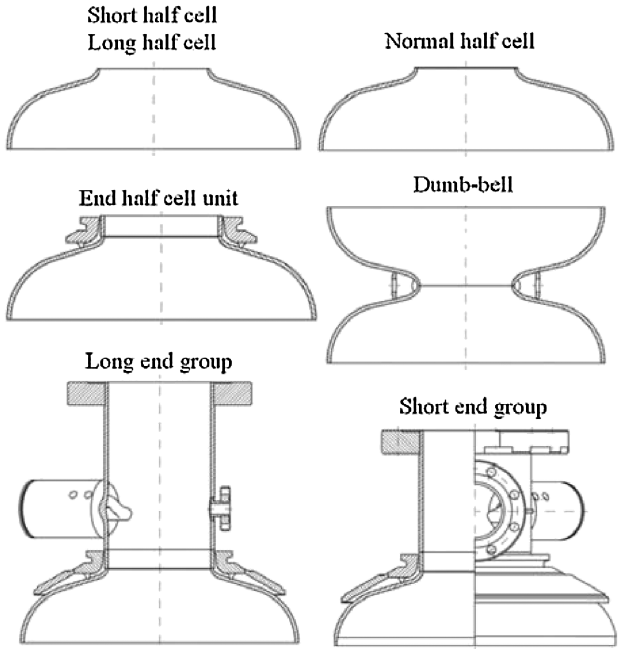
FIG. 11. Measurable parts of the 1.3 GHz nine-cell